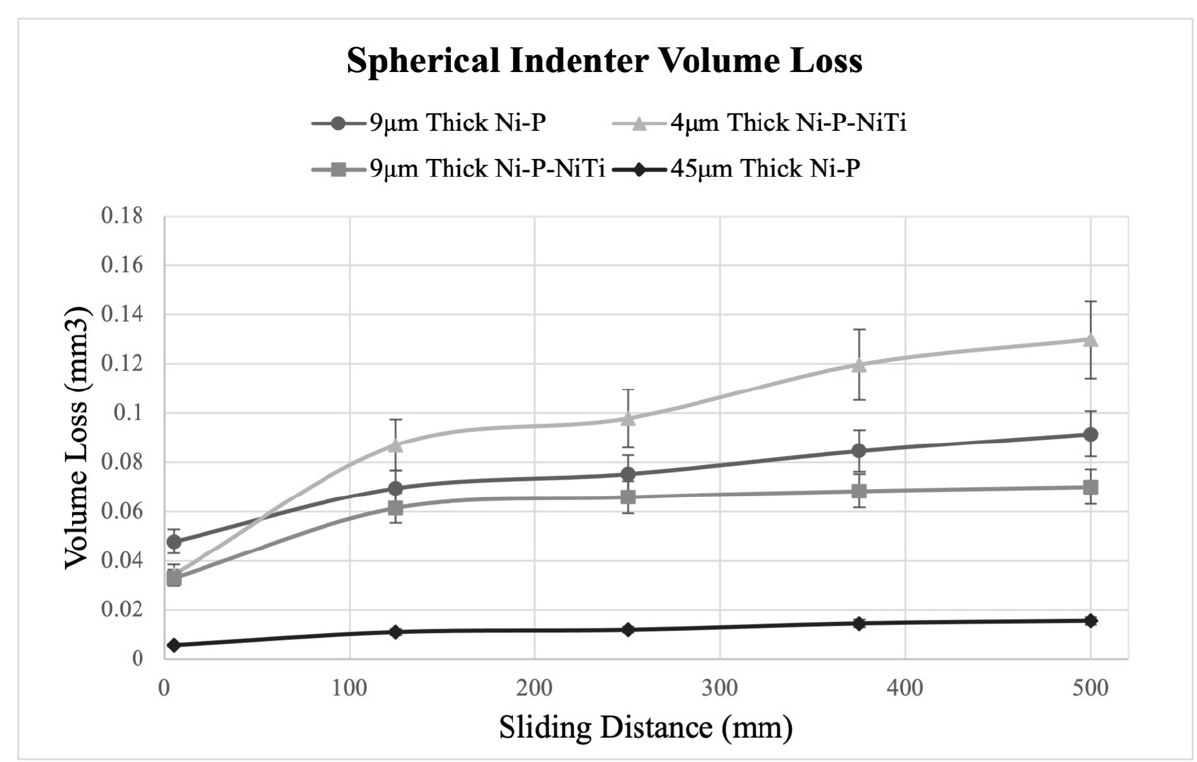
Figure 21. Volume Loss from the Spherical Indenter.